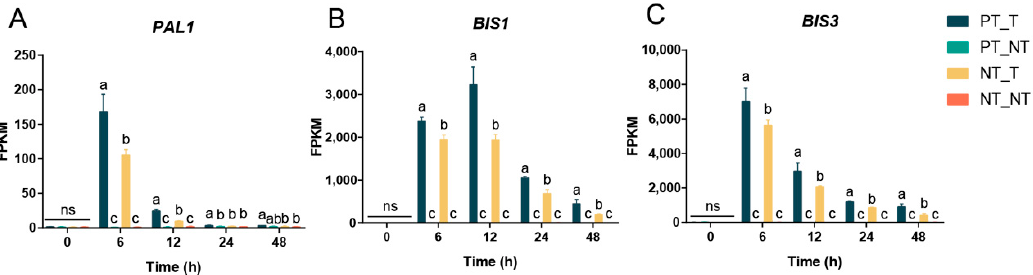
Figure 6. Expression levels of three selected genes in SPSCs in response to YE. ( A ) PAL1 , ( B ) BIS1 , and ( C ) BIS3 . Different lowercase letters above columns indicate statistical differences at p < 0.05 by one-way ANOVA ( n = 3). ns, not significant.